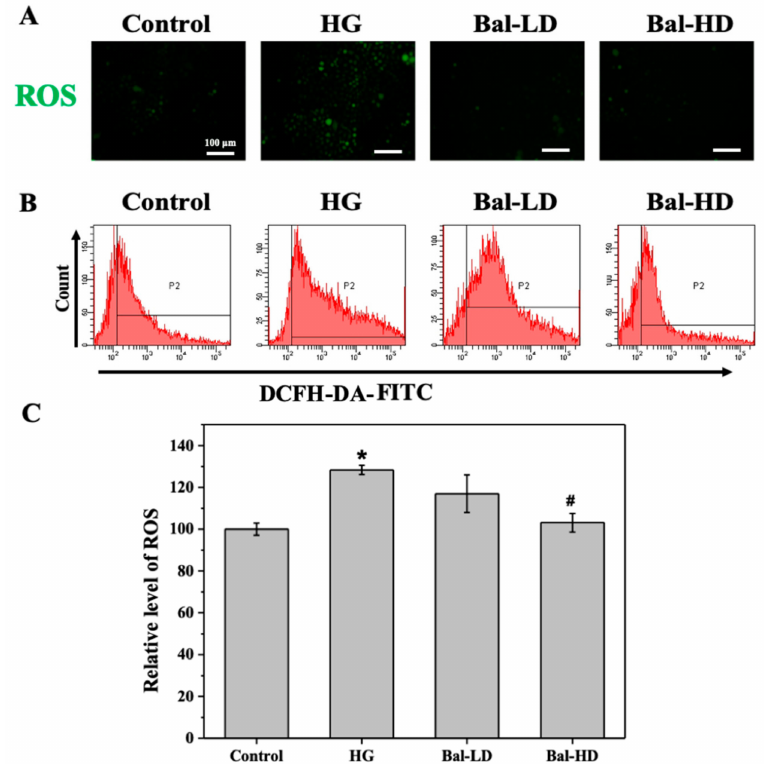
Figure 4. The e ff ect of baicalein on the intracellular level of reactive oxygen species (ROS) in HL-7702 cells induced by 60.5 mM of glucose. HL-7702 cells were exposed to 5.5 mM of glucose (Control), 60.5 mM of glucose (HG), 60.5 mM of glucose with 5 µ M of baicalein (Bal-LD), and 60.5 mM of glucose with 20 µ M of baicalein (Bal-HD) for 24 h. The level of ROS was assessed by fluorescence microscopy and flow cytometry. ( A ) Images indicating the level of ROS (green fluorescence) in HL-7702 cells. ( B ) The representative data of ROS-positive cells determined by flow cytometry. ( C ) The relative level of ROS in cells of each group revealed by flow cytometry. The data are shown as the mean ± SD ( n = 3). * p < 0.05 vs. control group; # p < 0.05 vs. HG